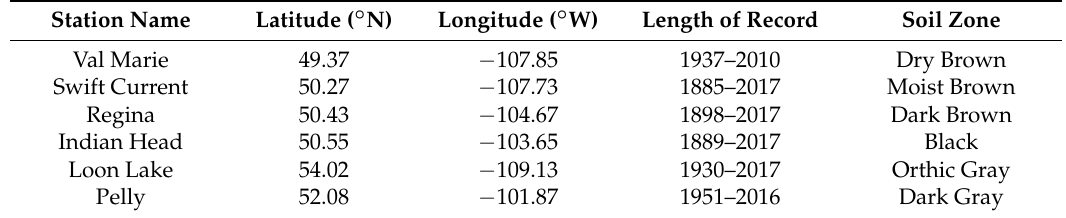
Table 1. Historical weather station